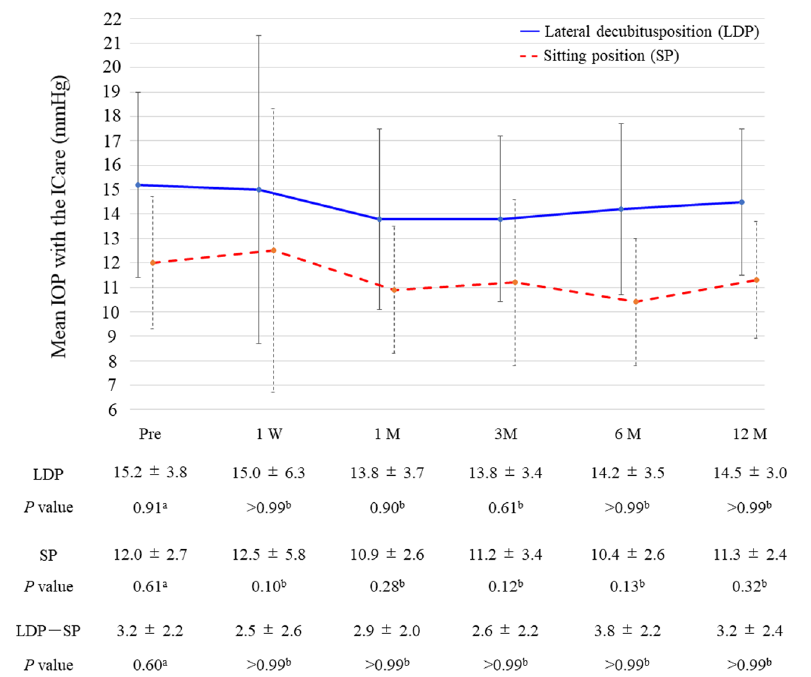
Figure 3. Changes in mean IOP were measured in the sitting and lateral decubitus positions with the ICare throughout follow-up. The error bar shows the standard deviation. IOP, intraocular pressure; W, week; M, month. P -values: a one-way repeated measures ANOVA; b paired t -test versus baseline with Bonferroni correction.